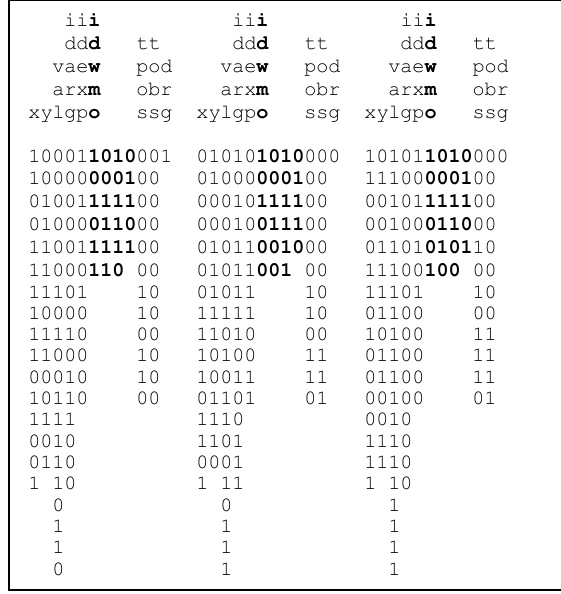
Table 5. Compressed data with prolonged bit length per row for column idwmo (printed in